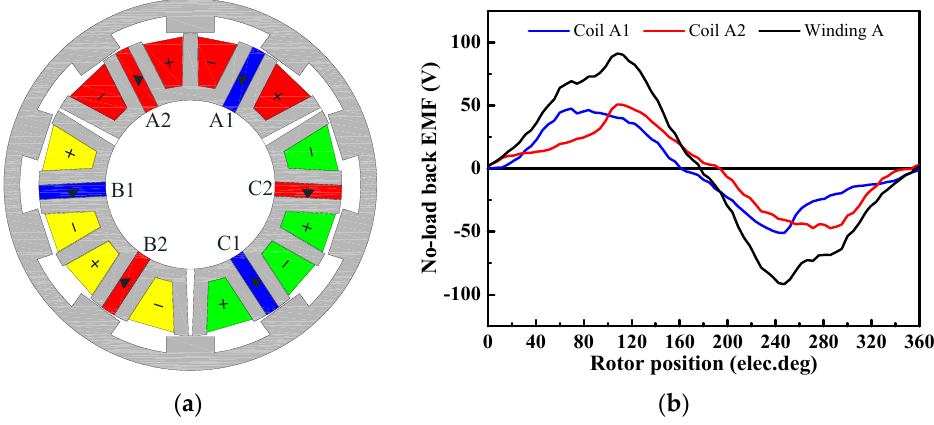
Figure 5. 12-slot/10-pole MSOR-FSPM motor: ( a ) Cross-sectional view of the 12-slot/10-pole MSOR-FSPM motor; ( b ) No-load back-EMF waveforms of coil A1, coil A2, and winding A.